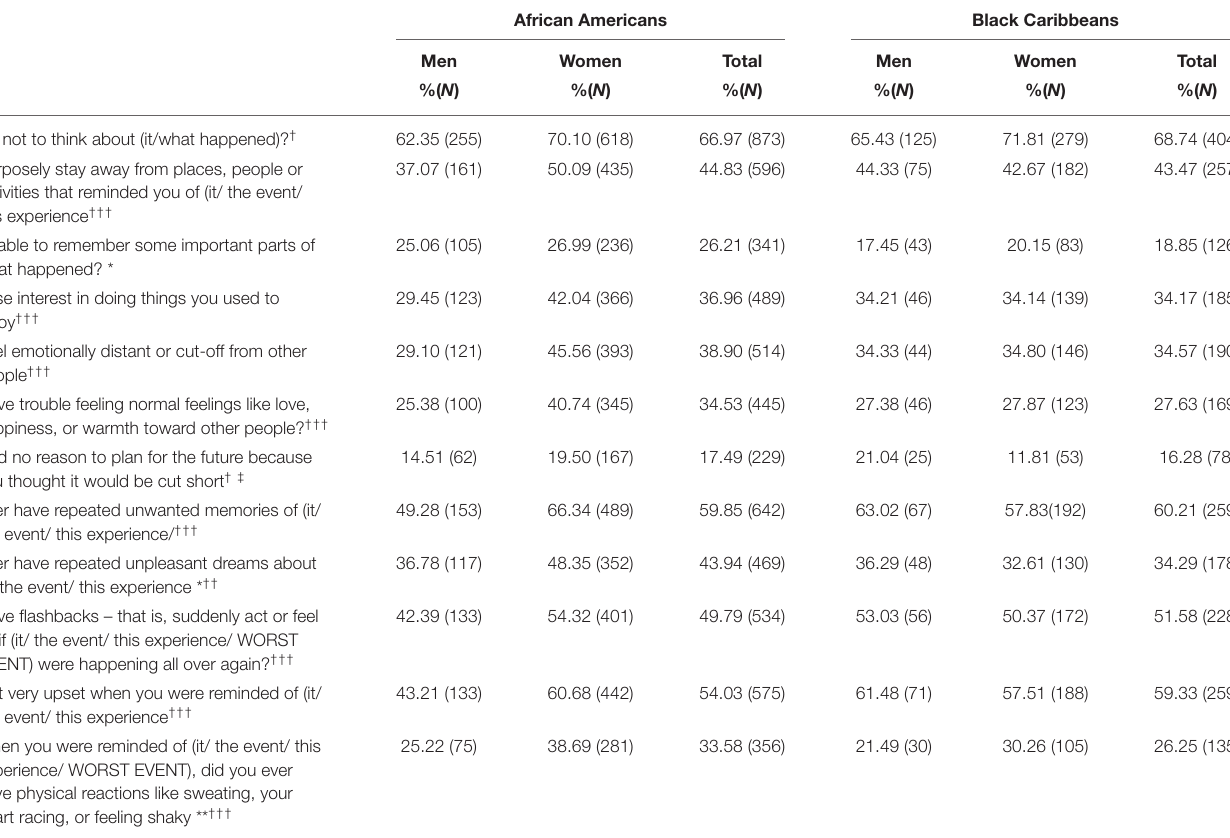
TABLE 4 | Sex and ethnic differences in PTSD symptomatology for Black Americans by sex and